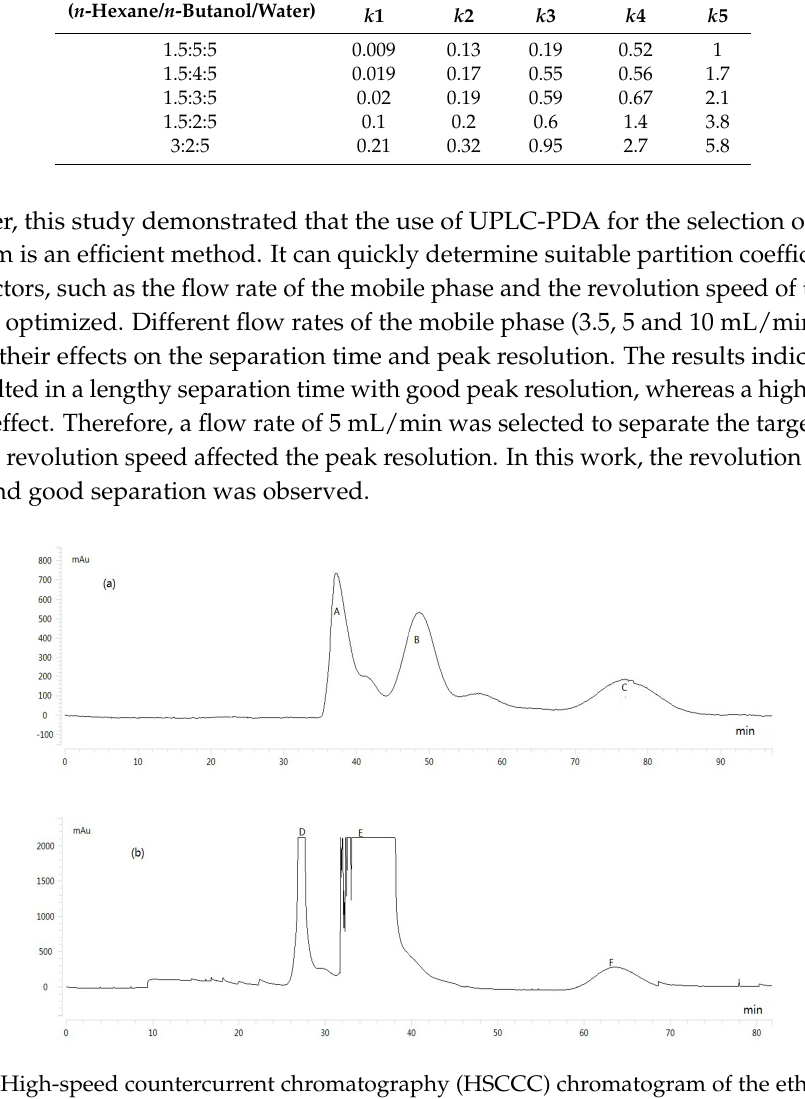
Table 1. k -values of five compounds in various solvent system.